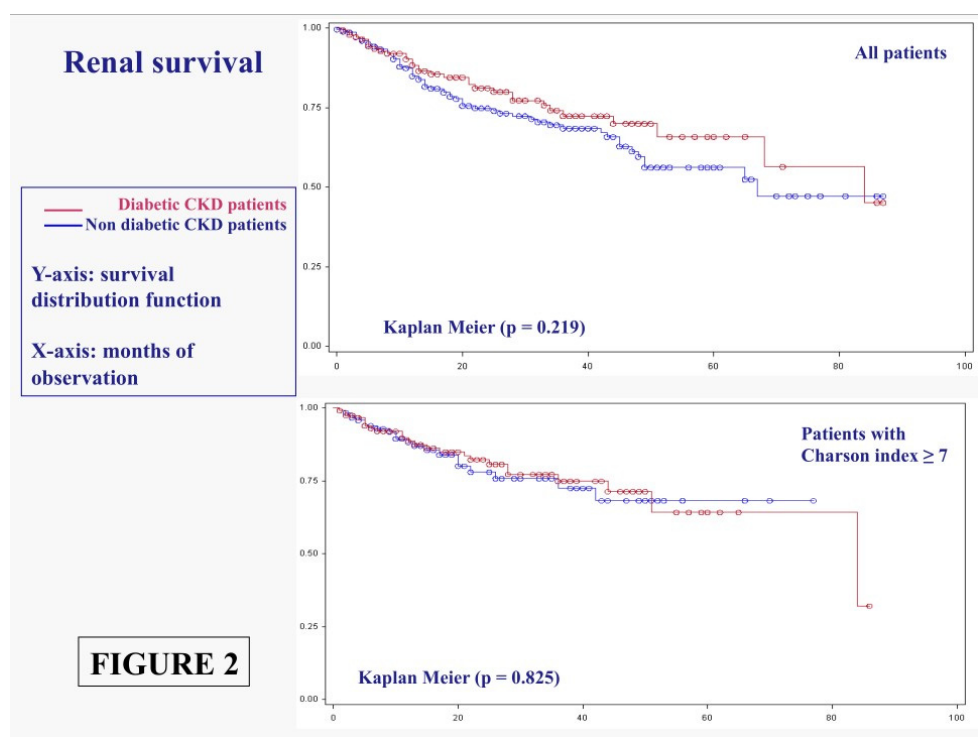
Figure 2. Time to start of the renal replacement therapy in diabetic and non ‐ diabetic CKD patients: All cases and patients with Charlson index ≥ 7. Nutrients 2016 , 8 , 649